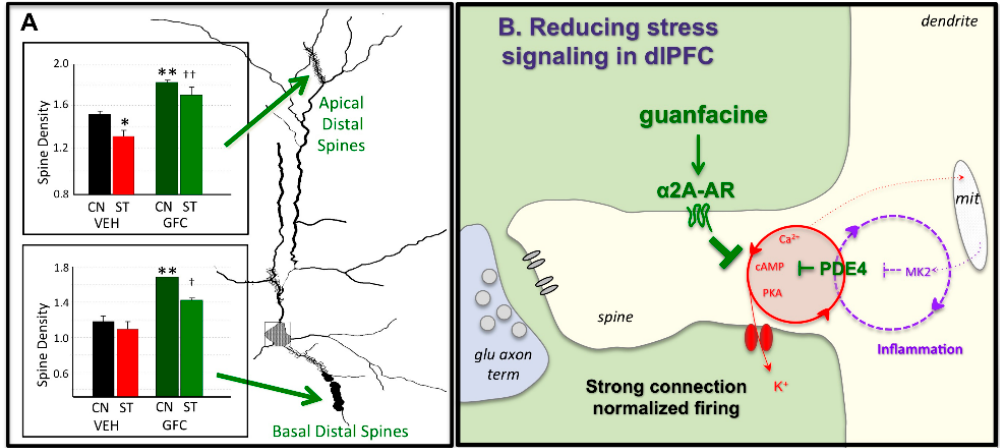
Figure 4. The α 2A-AR agonist guanfacine can strengthen PFC connectivity and protect the PFC from stress. ( A ) Chronic restraint stress causes loss of apical distal spines from layer II / III prelimbic PFC pyramidal cells in rats. Daily pre-treatment with guanfacine prevents spine loss and protects working memory function. CN = control, ST = chronic restraint stress, VEH = vehicle, GFC = guanfacine. * or ** significantly di ff erent from vehicle control; † or †† significantly di ff erent from vehicle stress at p < 0.05 or 0.01 levels, respectively. Figure 4A adapted from [93]. ( B ) Schematic diagram showing that guanfacine stimulation of α 2A-AR on spines strengthens connectivity and protects PFC from stress by inhibiting cAMP-calcium-K + channel signaling.